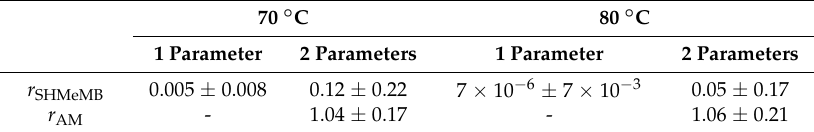
Table 3. Reactivity ratios estimates from copolymerization of 3:7 molar ratio of SHMeMB:AM with 15 wt % monomer and 0.5 wt % V-50 at 70 and 80 ◦ C. The “one parameter” method estimates r SHMeMB with r AM fixed at 0.951, and the “two parameter” method estimates both r AM and r SHMeMB . 70 ◦ C 80 ◦